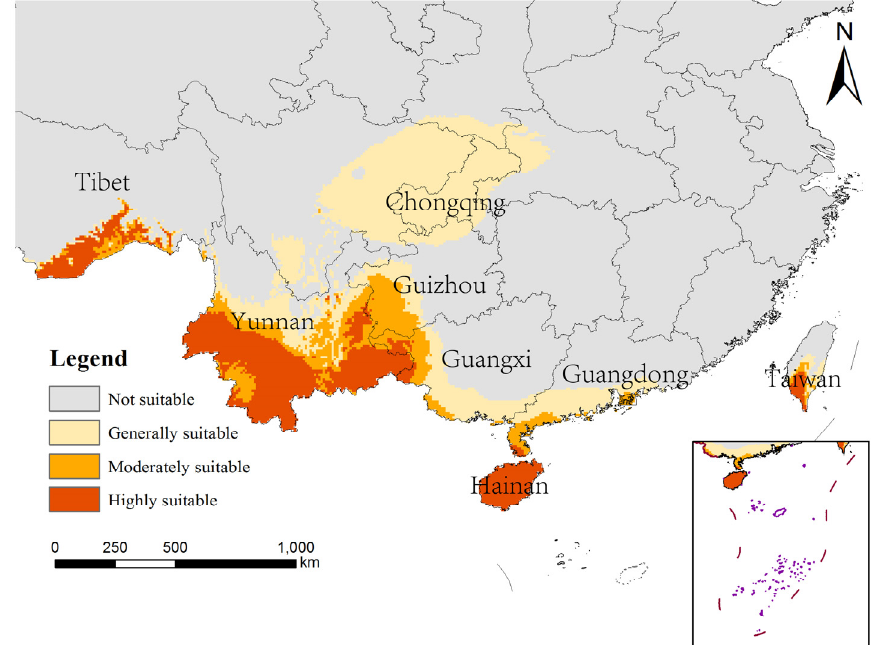
Figure 8. Distribution of potentially suitable areas for Anopheles nivipes in China under SSP585 climate scenarios in 2061–2080s. Table 2. Project level and comprehensive risk value of risk assessment indicators of An. philippinensis and An. nivipes .